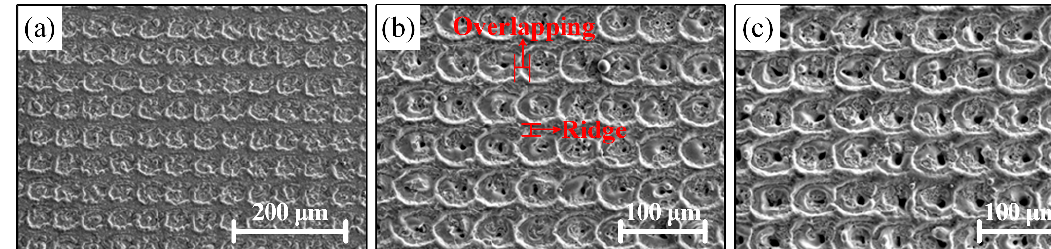
Figure 4. Microdimple structural morphology under different average laser powers: ( a ) 10 W; ( b ) 14 W; ( c ) 18 W.